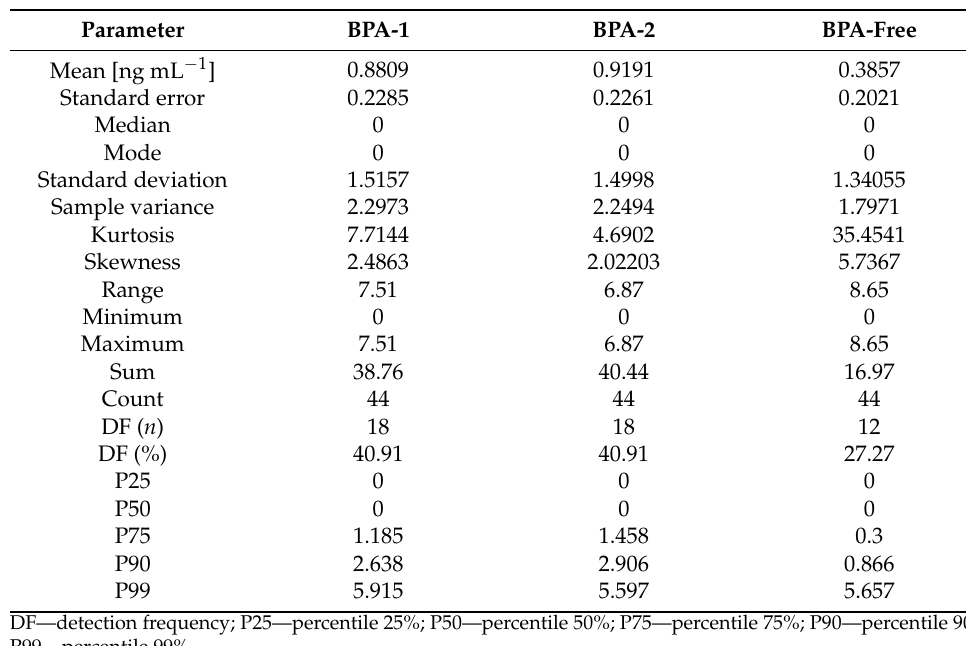
Table 5. Descriptive statistics for UHPLC–MS/MS measurements of AH samples taken from the entire population of the studied subjects ( n = 44).